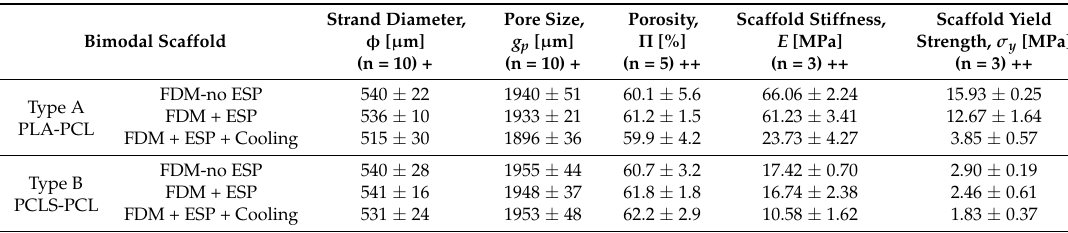
Figure 3. SEM micrographs: ( a ) Top section view of Type B scaffold (FDM + ESP + Cooling); and ( b ) cross section view of Type B scaffold (FDM + ESP + Cooling). Table 4. Morphology and mechanical properties of bimodal scaffolds.